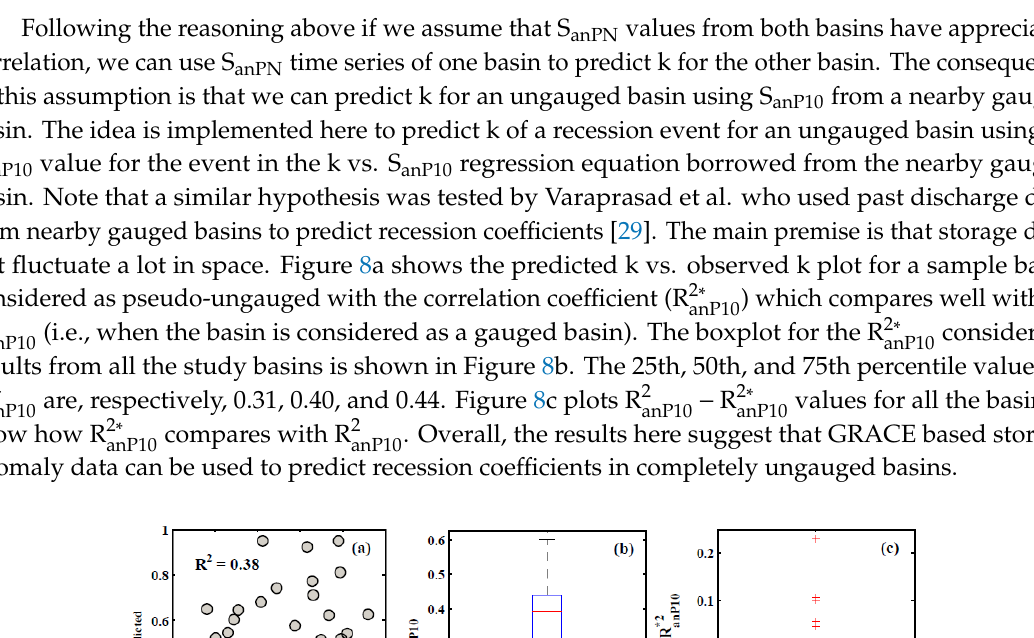
Figure 7. k vs. S an10 scatter plots for four sample basins (Basin ids 0317000, 07268000, 03463300, and 03237500) shown together. The idea is to imply that k-S anPN relationship is not universal, and, therefore, it is not possible for us to use S anPN data for predicting streamflow in ungauged basins.